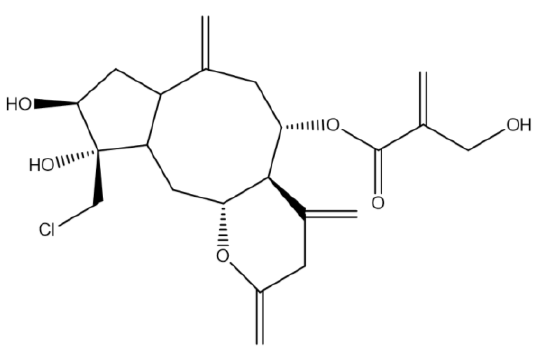
Figure 9. Chemical structure of chlorojanerin, which was isolated from the chloroform fraction of C. maximus .